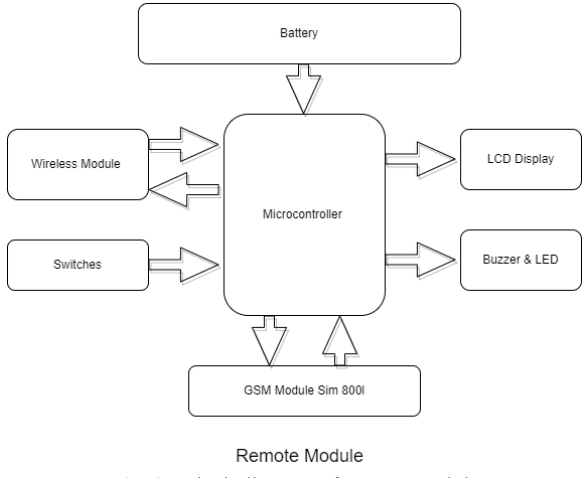
Fig. 2. Block diagram of remote module